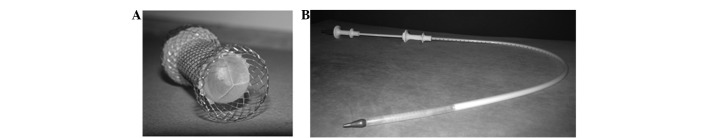
(A) Radioactive stent and (B) its auxiliary equipment.